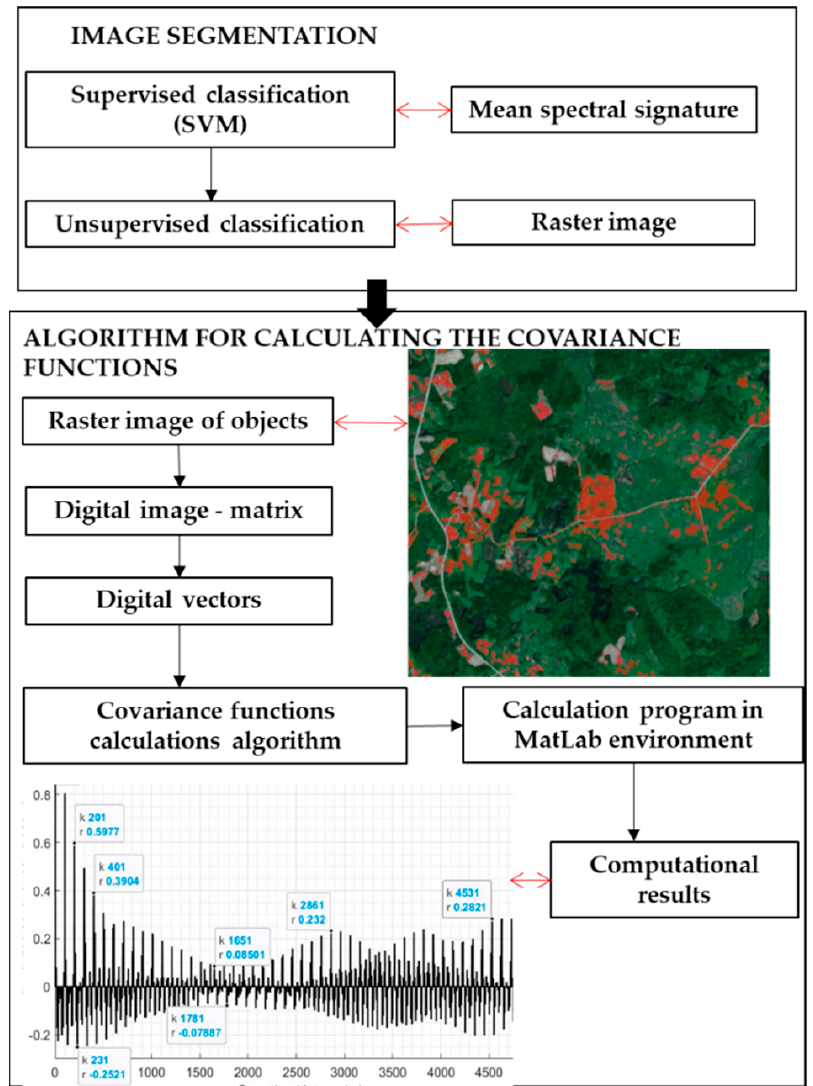
Figure 2. Schematic view of the image processing method used (source: authors).